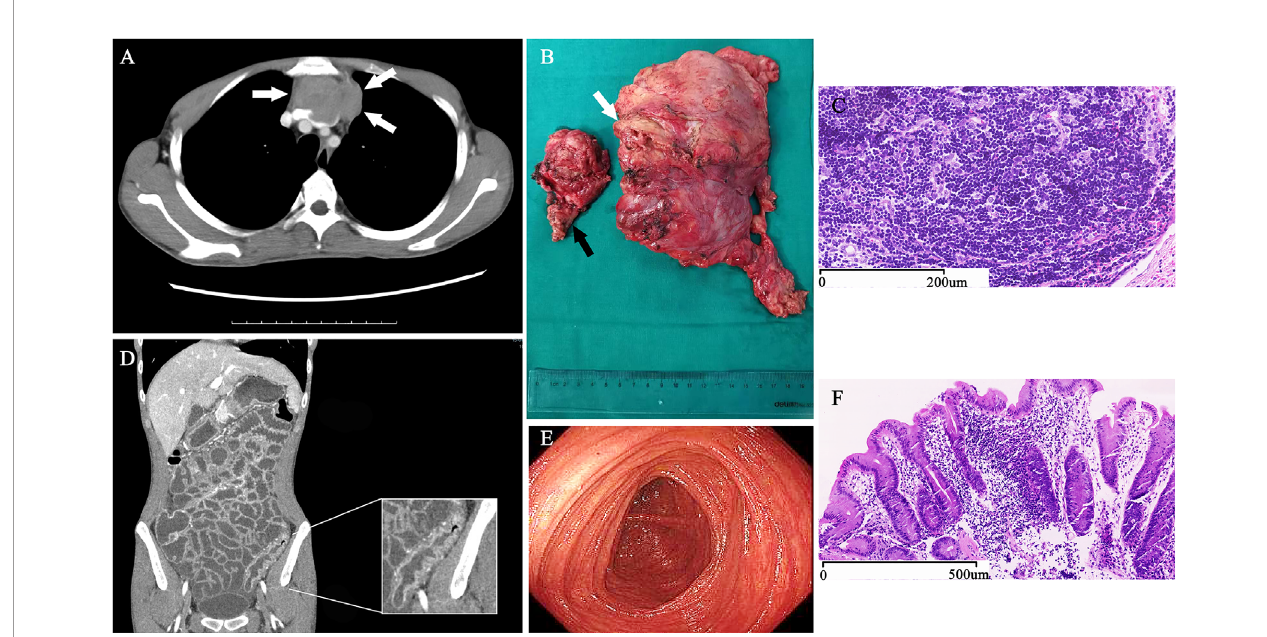
FIGURE 1 | Diagnostic Evidence of Thymoma with Autoimmune Enteropathy and Myocarditis. An axial, CT contrast-enhanced scan of the chest (A) shows a mediastinal mass (arrows) invading into the left anonymous vein. During surgery, we found that not only the left anonymous vein (white arrow) but also the anterior segment of left-upper lobe (black arrow) were involved by the thymoma (B) . The pathological sections of tumor stained with hematoxylin and eosin shows typical B1 thymoma (C) . A coronal, CT contrast-enhanced scan of the abdomen and pelvis (D) shows the typical thickening and high-density of the colon wall. The enteroscopy (E) showed the sigmoid colonic mucosa was markedly thinner than normal, and the colon mucosal biopsies (F) detected the colonic mucosa with chronic in fl ammation, mild lymphocytosis, and extensive loss of goblet